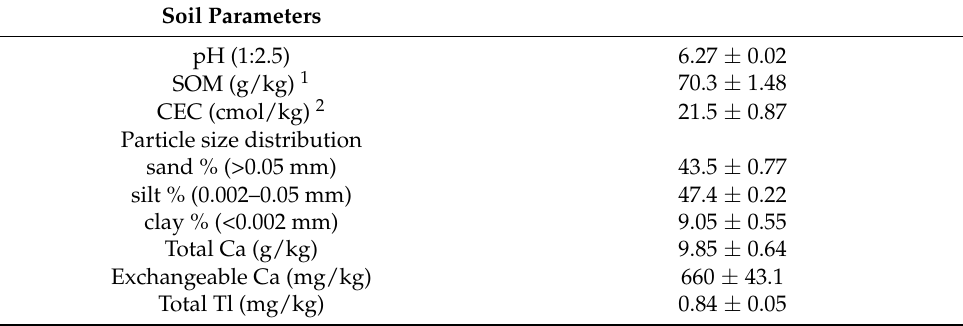
Table 1. Physicochemical properties of the pot soil (mean ± sd, n =